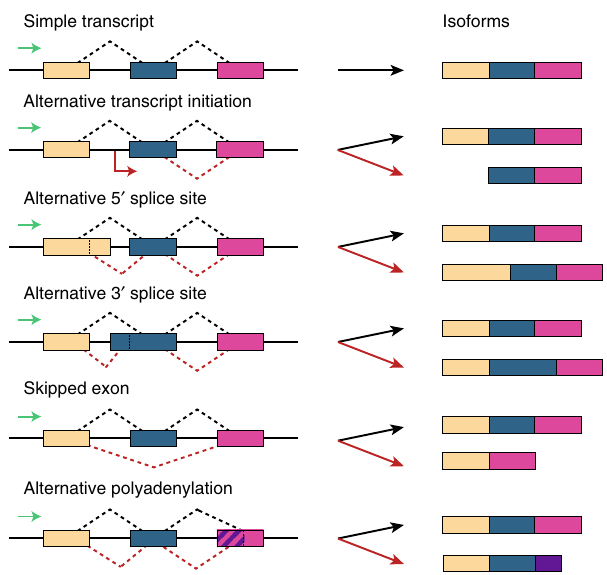
Fig. 1 Alternative splicing mechanisms. A single gene may be transcribed into several distinct mRNA variants called isoforms through alternative splicing mechanisms. This fi gure shows six common types of splicing events (top to bottom): simple transcript; alternative transcription start site; alternative 5 ′ splice site; alternative 3 ′ splice site; skipped exon;